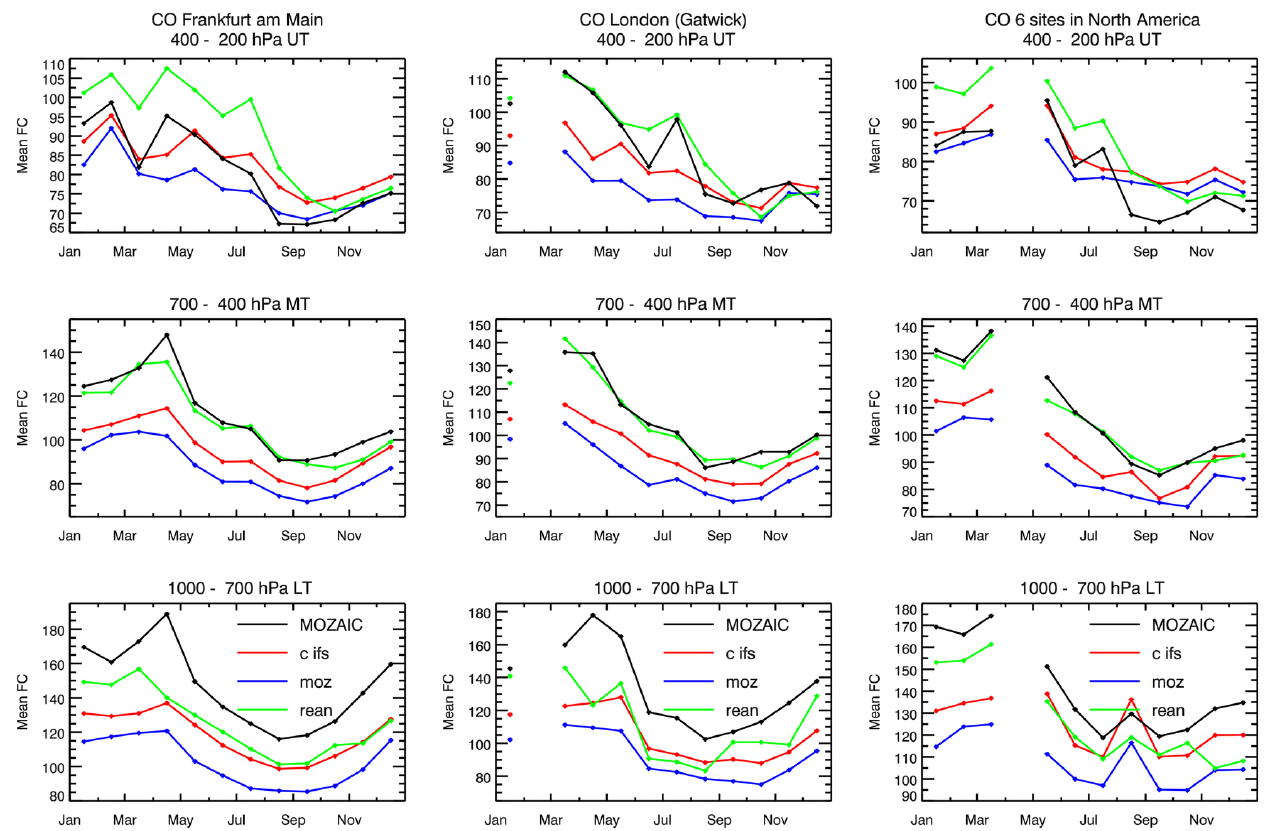
Figure 8. CO volume mixing ratios (ppb) over Frankfurt (left), London (middle) and North America (left, averaged over six airports) averaged in the pressure bands 1000–700hPa (bottom), 700–400hPa (middle) and 400–200hPa (top) observed by MOZAIC and simulated by C-IFS (red), MOZ (blue) and REAN (green) in